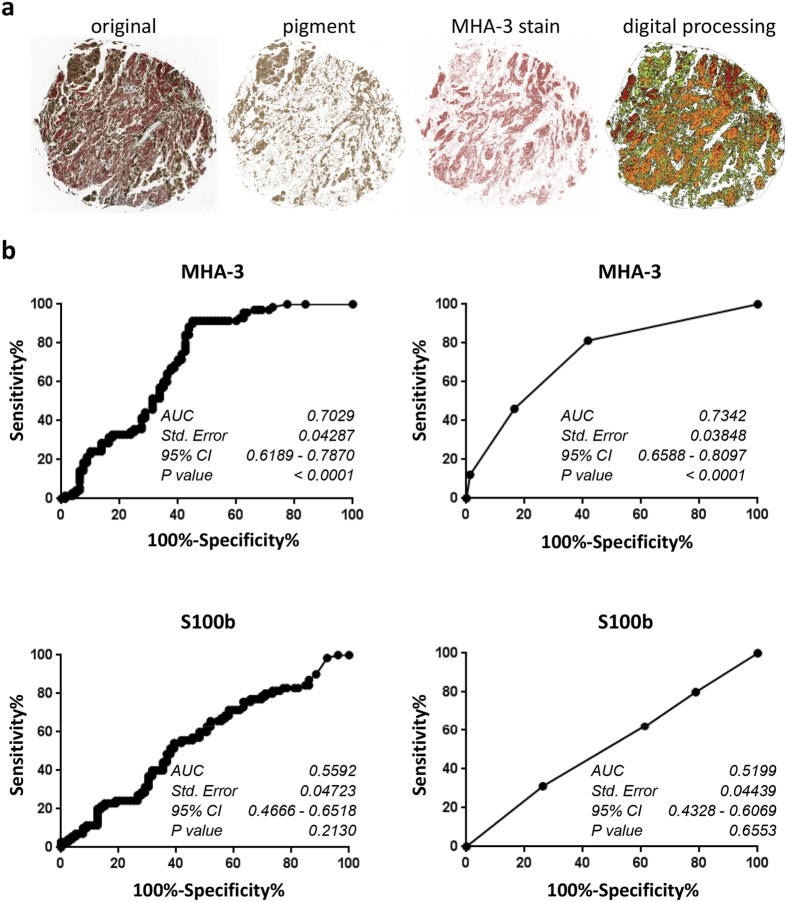
Detection of melanoma metastasis by MHA-3.(a) Example of digital processing for staining quantification. The cores of the melanoma arrays (n = 236) were scanned and subjected to colour deconvolution, which removed brown pigment stain and allowed software-assisted quantification of positive area (shown in red and orange colour). (b) ROC curves were calculated based non-metastatic melanoma vs. metastatic melanoma staining intensities for MHA-3 and S100b. ROC curves on the left were derived from digital images, whereas the curves on the right were derived from two independent observers.